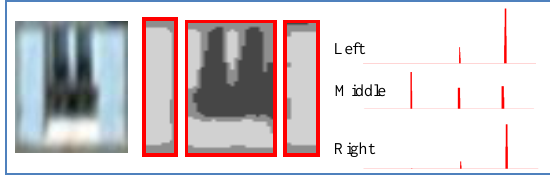
Figure 12. Shutter detection: the number of colour is reduced to 3, the image is cut in 3 parts at ¼, and ¾ of the width; histograms show a clear dominance at the same value for both